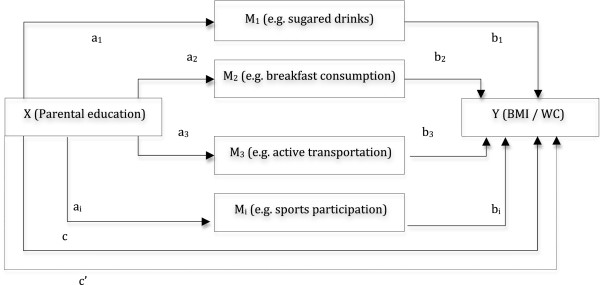
Multiple mediator model. X: predictor variable; Y: outcome variable; Mi: mediator variable; ai: association between predictor (X) and potential mediator (Mi); bi: association between potential mediator (Mi) and outcome variable (Y); c: overall association between predictor variable (X) and outcome variable (Y); c’: direct effect (unmediated) of predictor variable (X) on outcome variable (Y).